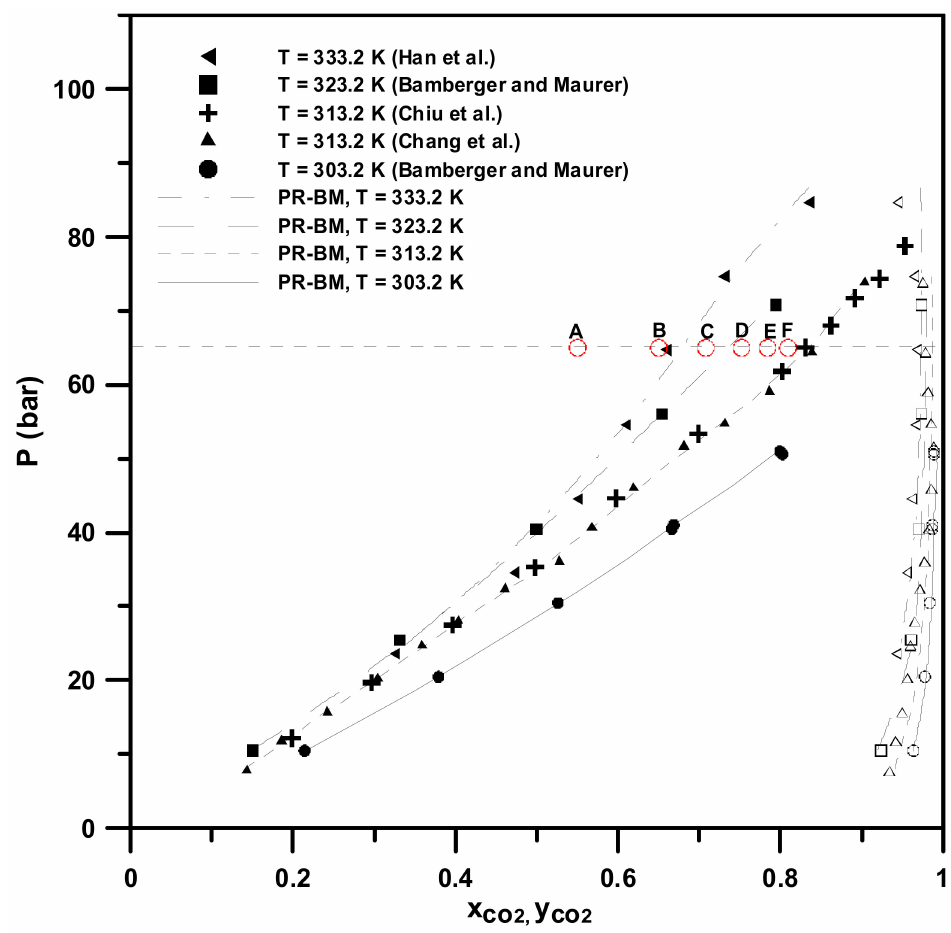
Figure 1. VLE phase diagram of the mixture of carbon dioxide + acetone. Points A, B, C, D, E, and F are referred to R values of 0.8, 1.2, 1.6, 2.0, 2.4, and 2.8,